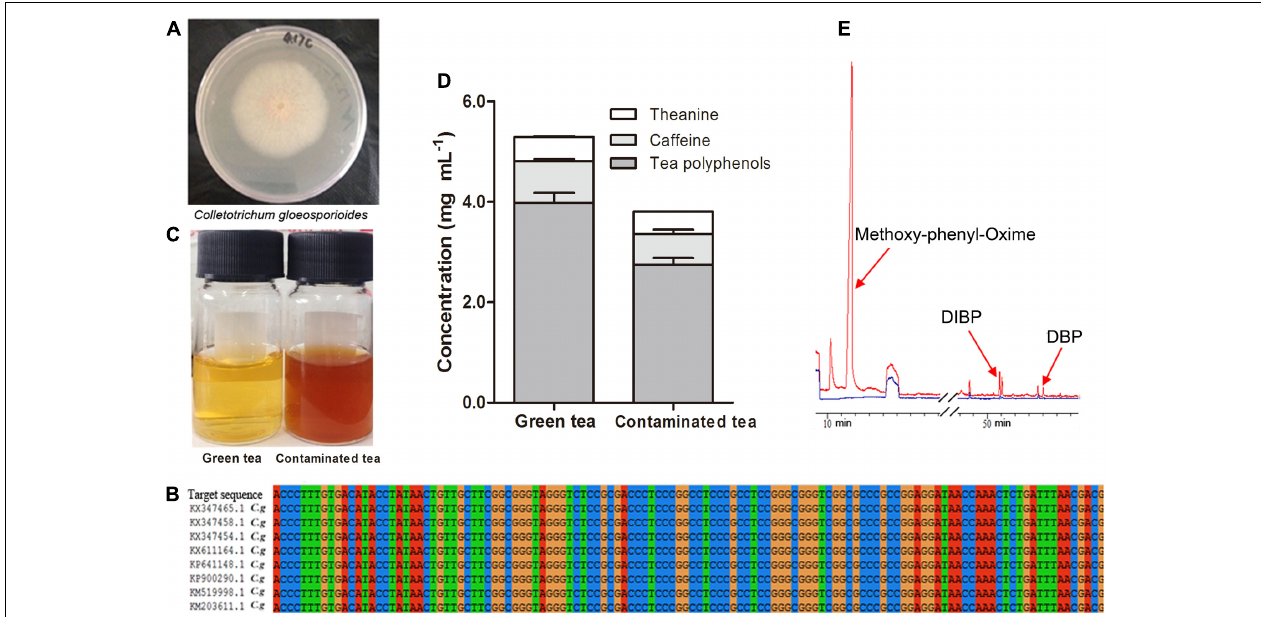
FIGURE 1 | Colletotrichum gloeosporioides and the influence on green tea infusion. The colony shape of C. gloeosporioides (A) and comparison of nucleotide sequences in ITS region on NCBI (B) . Optical image of green tea and C. gloeosporioides -contaminated tea (C) . Changes of functional components contents (D) . GC/MS chromatograms of green tea (blue) and contaminated tea (red) (E) . Mean +